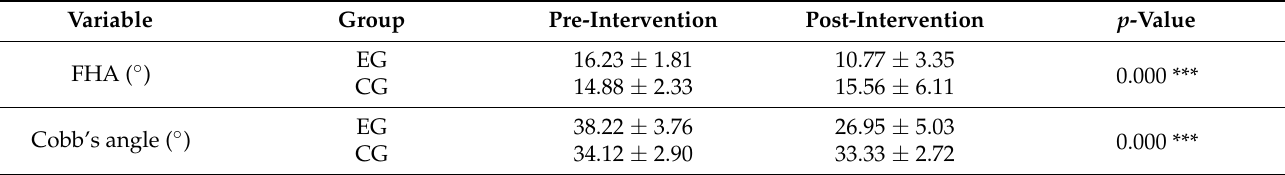
Table 3. Result of changes in structural variables.